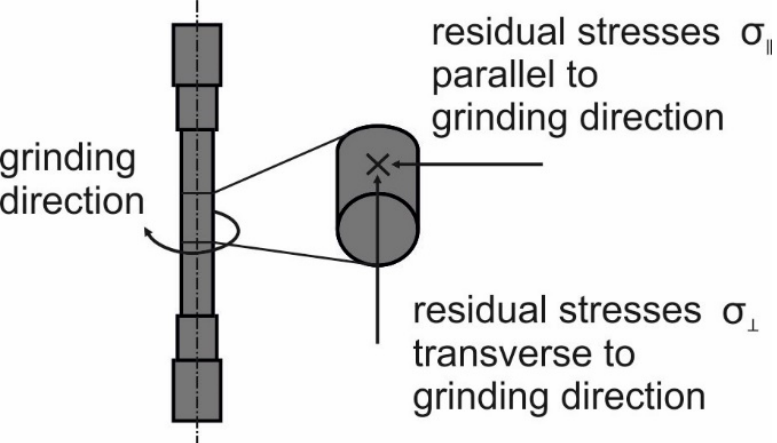
Figure 6. Grinding direction and directions of the measured residual stresses on the specimens. For the measurements in depth direction, material was removed by electrolytic pol- ishing accordingly. Since all residual stress measurements were conducted with the pre- viously mentioned setup and application, the measurement errors and the specific influ- ence of the measurement system can be assumed as nearly constant. In addition to the investigation of the residual stresses, the FWHM is also considered in this work. The FWHM indicates the appearance of local changes in the lattice plane distances. There are many causes for local changes in the lattice plane distances, such as alloying elements, precipitations or microstresses. Microstrains can emerge from either thermal or plastic deformation [25]. Generally, an increase in the amount of grain boundaries and dislocations cause a broadening of the interference peak [26,27]. Therefore, the FWHM can also be used to evaluate strain hardening effects [28,29]. The work hardening caused by grind-strengthening appears relatively close to the surface (approximately 100 µm or less), so that hardness measurements are useful to a limited extent. In this case, the FWHM can be used to assess the microstructural changes. The scanning electron microscopic investigations were carried out at a Vega II XLH Tescan. For an overview of the microstructural changes, deep-etched micrographs from cross-sections of the grind-strengthened specimens were viewed with the use of second- ary electron contrast. The cross-sections from the specimens were taken from the middle of the specimens. This approach allowed a higher magnified view on the microstructure. More detailed investigations of the specimens in FP-condition can be found in Ehle et al. [8]. 3. Results 3.1. Influence of Different Mechanical Loads on Grind-Strengthened Surface Layer Modifications The measured residual stress depth profiles after grind-strengthening and subse- quent loading with different mechanical loads are shown in Figure 7. The error bars rep- resent the standard deviation of two measured specimens. All specimens show very low residual stresses over the entire depth in the initial heat-treated state. The values fluctuate with 50 MPa around 0 MPa. The FP-annealed grind-strengthened specimens show the highest residual compres- sive stresses transverse to the grinding direction on the surface; see Figure 7a. The other variants show maximum residual stresses beneath the surface. The values at 20 µm be- neath the surface are similar for different measuring directions in the FP-condition and